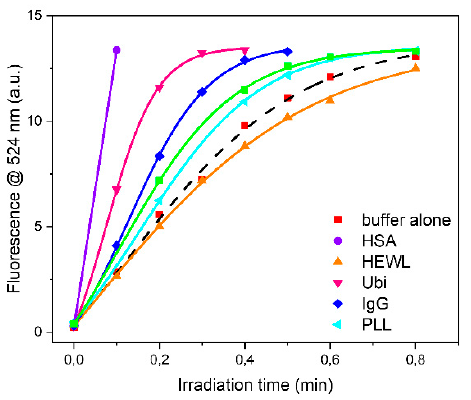
Figure 3 . Time-courses of DHR-123 conversion in 10 mM HEPES buffer, pH 7.00, in the presence of different proteins. Solutions were irradiated using UV-C lamps in a BioLink 254 photoreactor. Fluorescence spectra were recorded after excitation at 505 nm with a bandwidth of 4 nm.